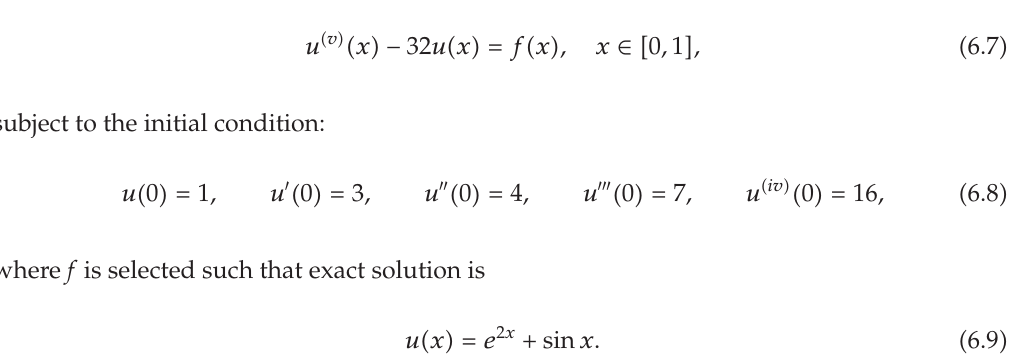
Table 2 list the Maximum pointwise error, using the P-SJG method with various